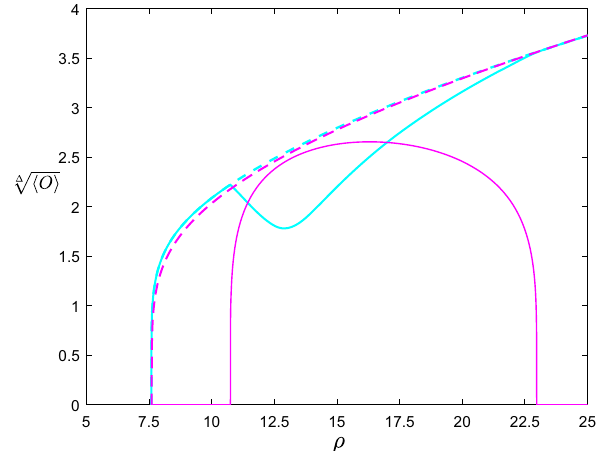
Fig. 2 The condensate values versus the charge density ρ with q p = 7189 / 10 , 000. The solid lines represents the condensate values for the most stable solution with both the s-wave and p-wave orders turned on. The dashed lines represents the condensate values for the solutions with only single condensate. The lines colored cyan is for the s-wave order, and lines colored magenta is for the p-wave order